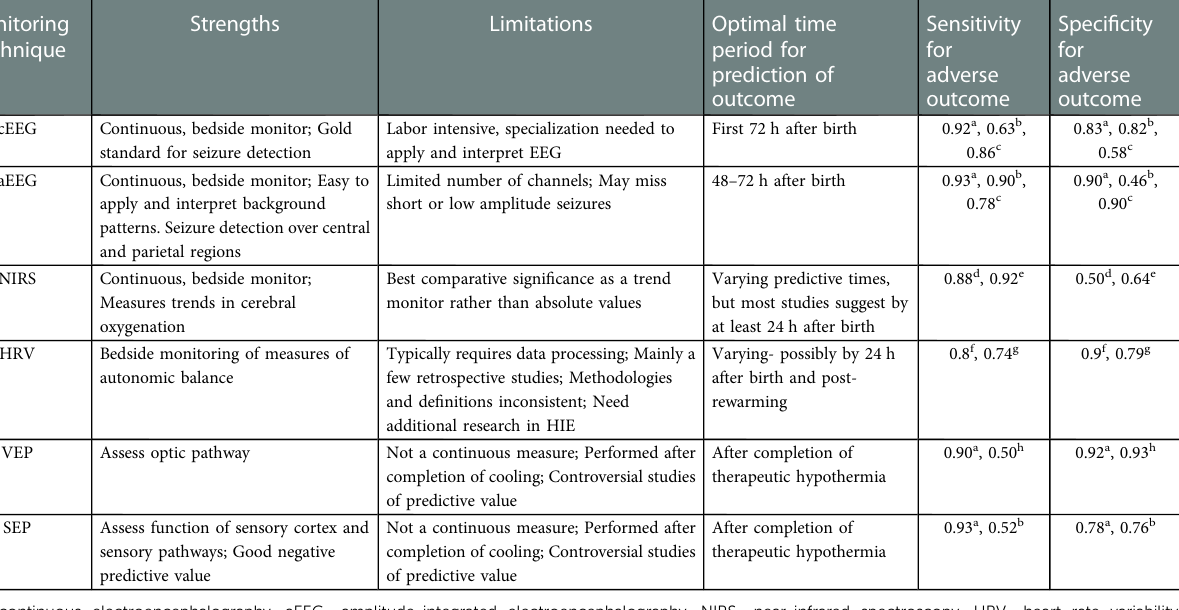
TABLE 2 Comparison of neuromonitoring